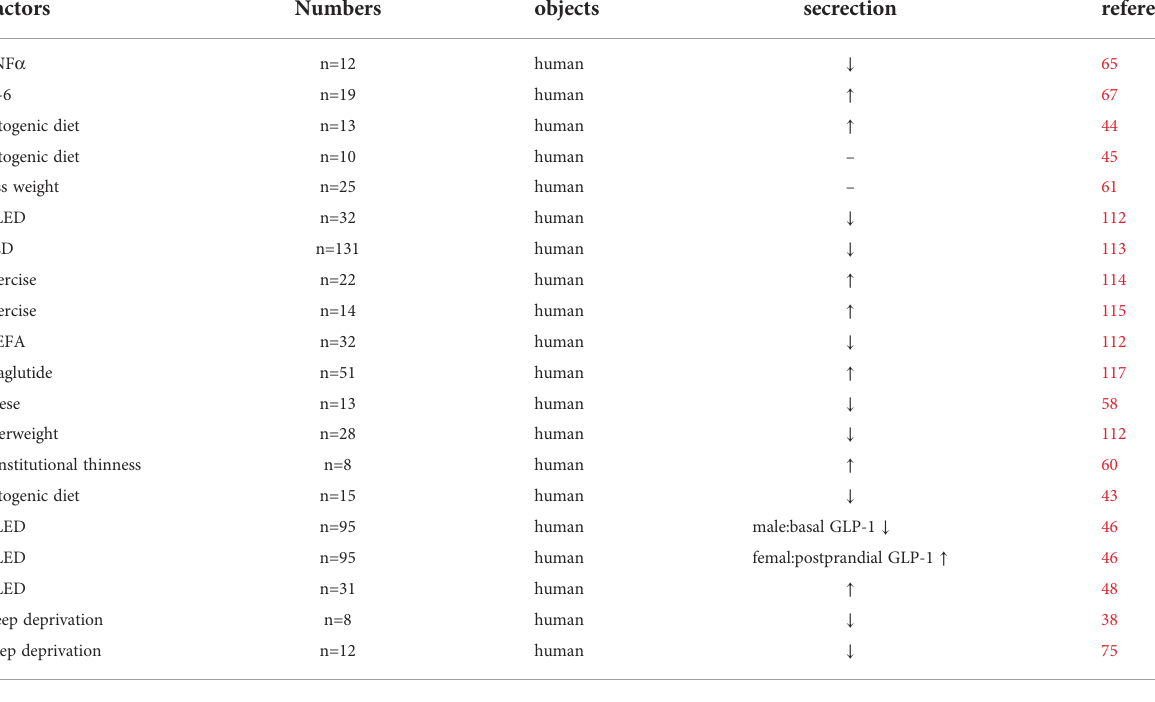
TABLE 1 Clinical studies affecting GLP-1 secretion.